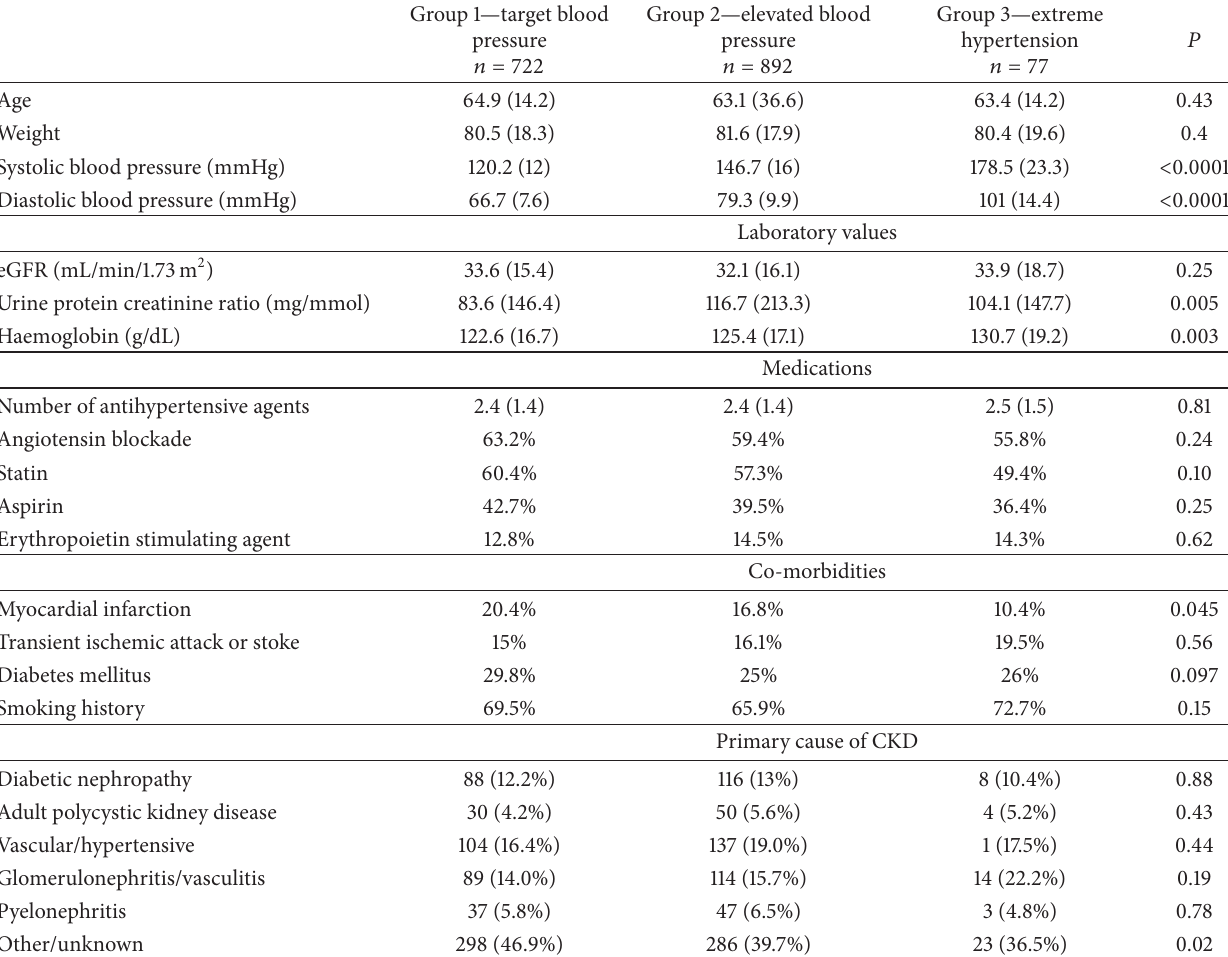
Table 1: Baseline patient characteristics divided by blood pressure